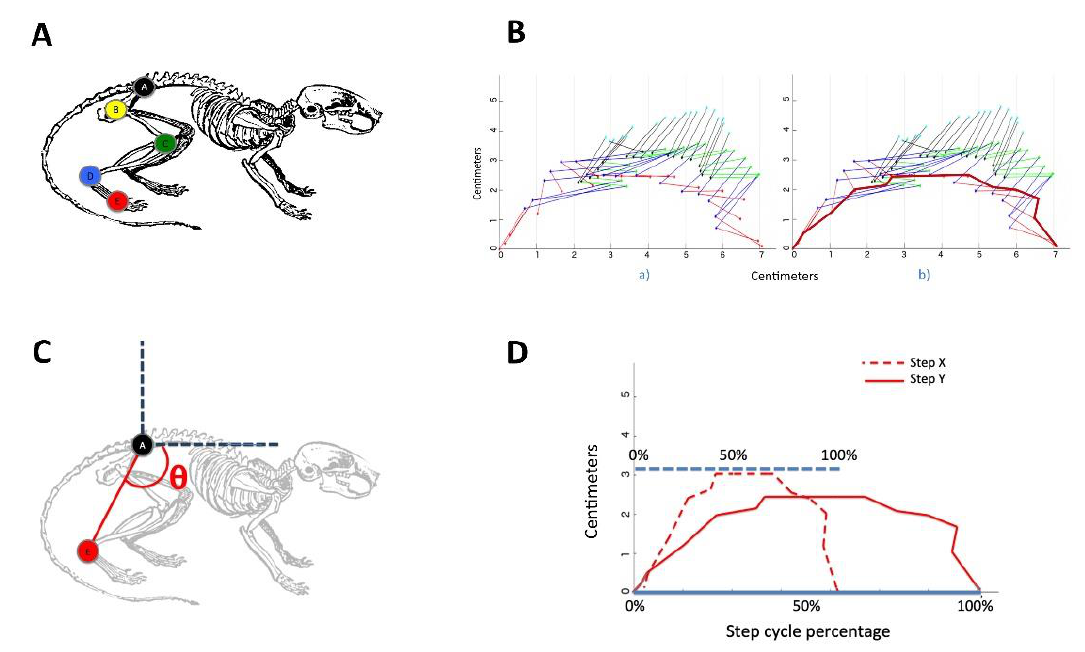
Figure 1. Method to evaluate di ff erent kinematic locomotion parametres. ( A ) Selected hindlimb joints for locomotion pattern analysis. Control, chronic and acute mice were marked at five points on the left and right hindlimbs using a nontoxic marker. ( B ) The di ff erent color lines illustrated di ff erent lines of segments between two market points. (a) An example of the pattern generated by the transition phase of a mouse, and (b) the curve corresponding to the amplitude of point E across time. ( C ) Depiction of the measured angle employed for the hindlimb pendulum-like movement analysis. ( D ) Depiction of two normalized curve patterns with respect to the step cycle.